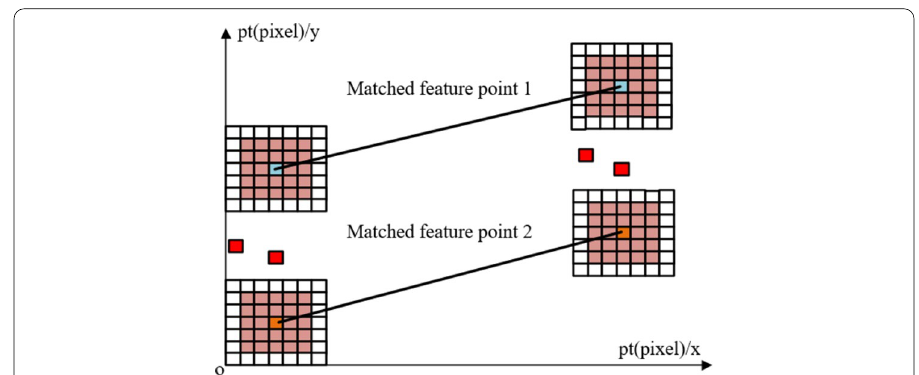
Fig. 6 Scope of the Hu